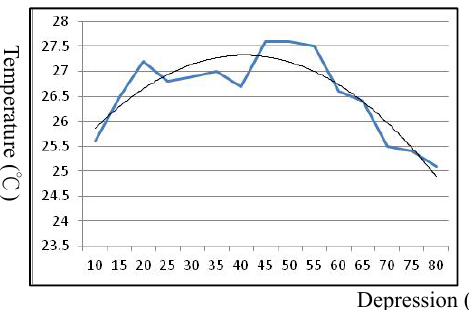
Figure 4. The graph of stainless temperature